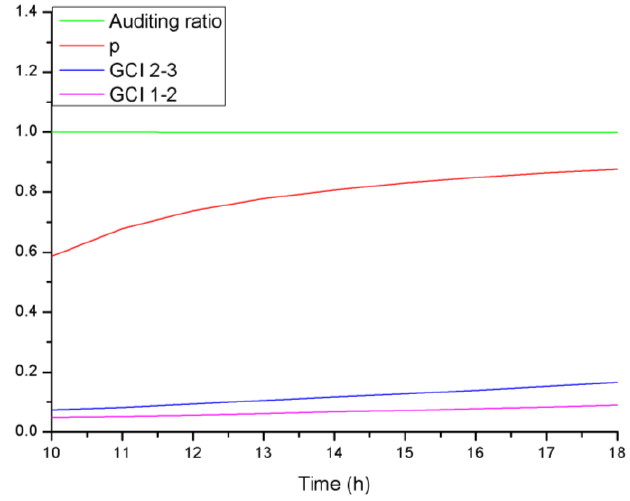
Figure 9. Grid convergence indexes, auditing ratio and order of convergence vs. time (grid spacing